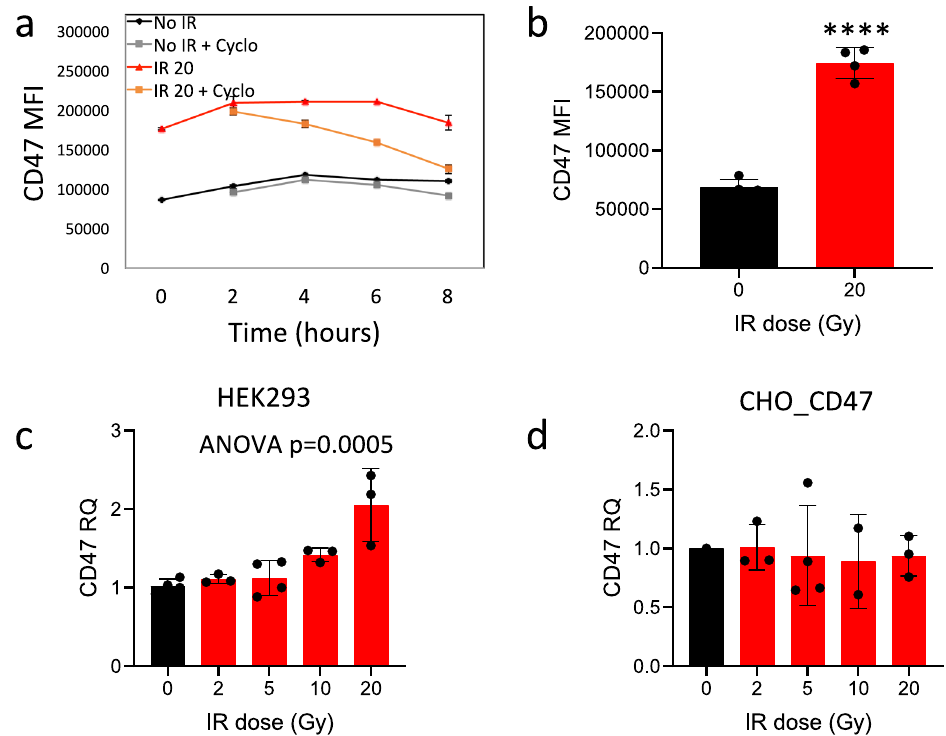
Fig. 2 γ -irradiation regulates CD47 overexpression at the transcriptional and translational levels. a 24 h after γ -irradiation (20 Gy) HEK-293T cells were treated with 2.5 µ M cycloheximide for the indicated time points (0 – 8 h) and then CD47 surface expression was determined by Flow cytometric analysis. b CD47 cell-surface and intracellular staining (MFI) in HEK-293T cells 24 h after γ -irradiation. Graphs show an average (±STD) of four replicates in each group. c , d qRT-PCR analysis for CD47 expression 24 h after γ -irradiation in HEK-293T cells ( c ) and CHO_CD47 cells ( d ) following γ -irradiation. Graphs show an average (± STD) of three replicates in each group. One of at least three independent experiments is shown. ** p < 0.005.